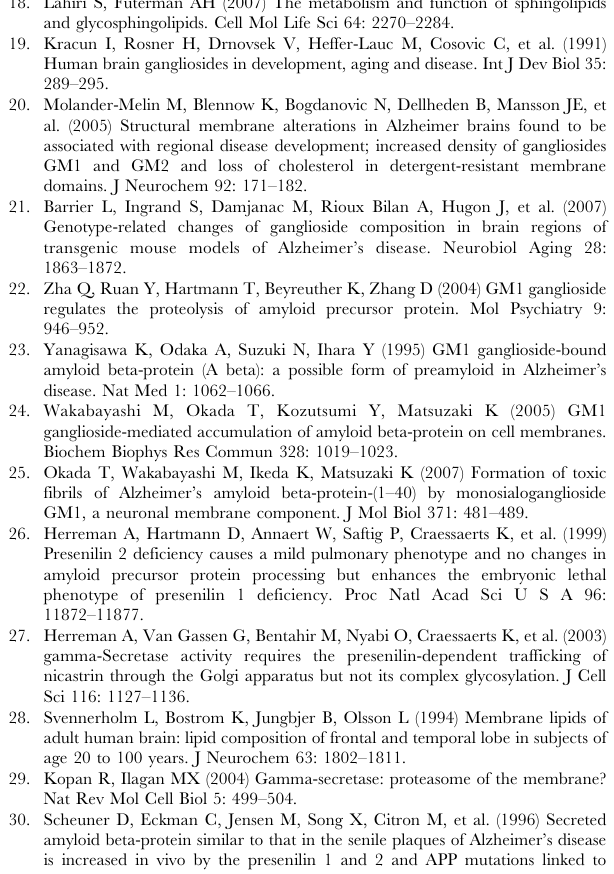
Figure S9 Control experiments using antibody WO2 for A b detection. (A) 5 ng, 10 ng, 20 ng and 40 ng of synthetic A b 40 and A b 42 peptides, respectively, were loaded and separated on Tris- Tricine gels. Western blot (WB) analysis to detect A b was performed with antibody WO2. (B) Human neuroblastoma SH- SY5Y cells were incubated with 2 m M c -secretase inhibitor X (Calbiochem, Darmstadt, Germany) and the solvent control. Conditioned media were immunoprecipitated with antibody WO2. Immunoprecipitated proteins were loaded and separated on a Tris-Tricine gel and detected via WB analysis using antibody WO2. In presence of c -secretase inhibitor, A b cannot be detected (negative control). (C) Human neuroblastoma SH-SY5Y cells were incubated with 100 m M GM1 and the solvent control. Condi- tioned media were immunoprecipitated with antibody WO2. Immunoprecipitated proteins were loaded and separated on a Tris-Tricine gel. WB analysis was performed with antibody WO2. GM1 increases A b generation (positive control). Figure S10 Staining of gangliosides separated via TLC using iodine, orcinol and resorcinol. Brain samples and ganglioside standard were separated via TLC as described in the material and method section and stained with iodine, orcinol and resorcinol. TLC1 was first stained with iodine and afterwards with orcinol. TLC2 was first stained with iodine and afterwards with resorcinol. This analysis shows that gangliosides (GM3, GM1, GD3, GD1a, GD1b and GT1b) can be stained with iodine, orcinol and resorcinol. (TIF)